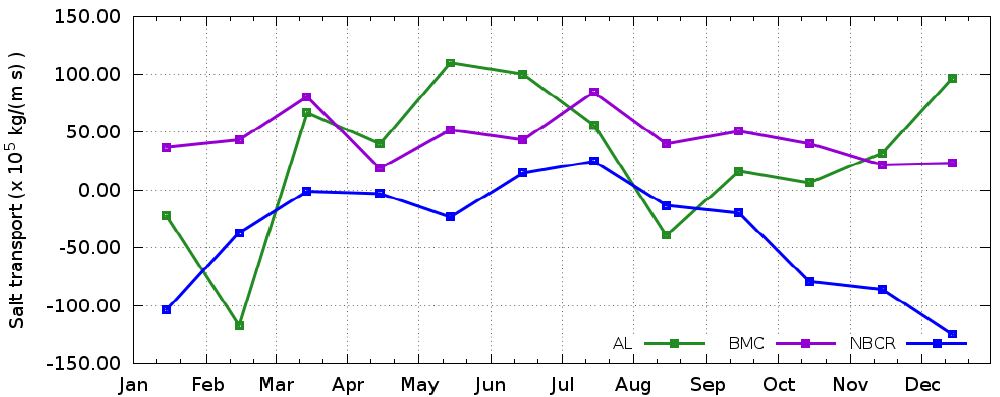
Figure 8. Salt zonal transport per unit depth for the North Brazil Current Retroflection (NBCR), the Brazil-Malvinas Confluence (BMC), and the Agulhas Leakage (AL). In all cases, the integration is over 4° of latitude, as explained in the text, with positive/negative values denoting eastward/westward transports.